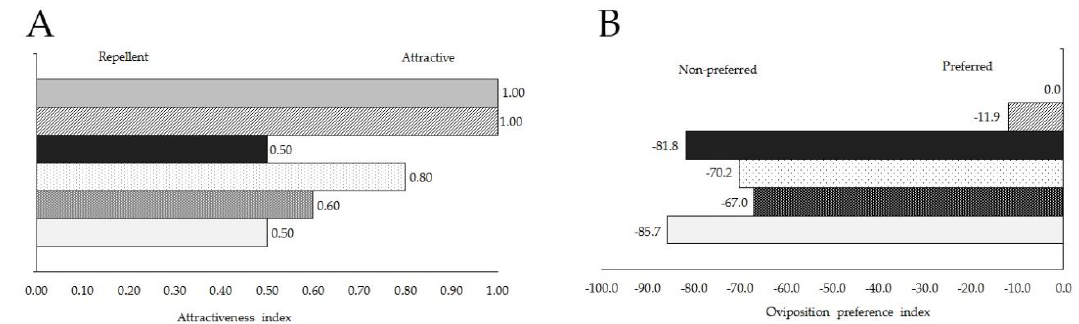
Figure 4. Tuta absoluta responses to tomato genotypes in choice bioassays. ( A ) Attractiveness index of genotypes for adults of T. absoluta . ( B ) Oviposition preference index of T. absoluta in relation to genotypes. The data regarding the number of individuals were transformed by (x + 0.5) 1/2 .